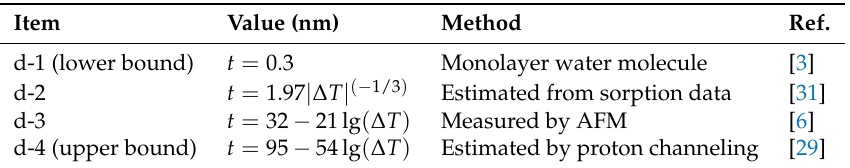
Table 1. Selected t − T